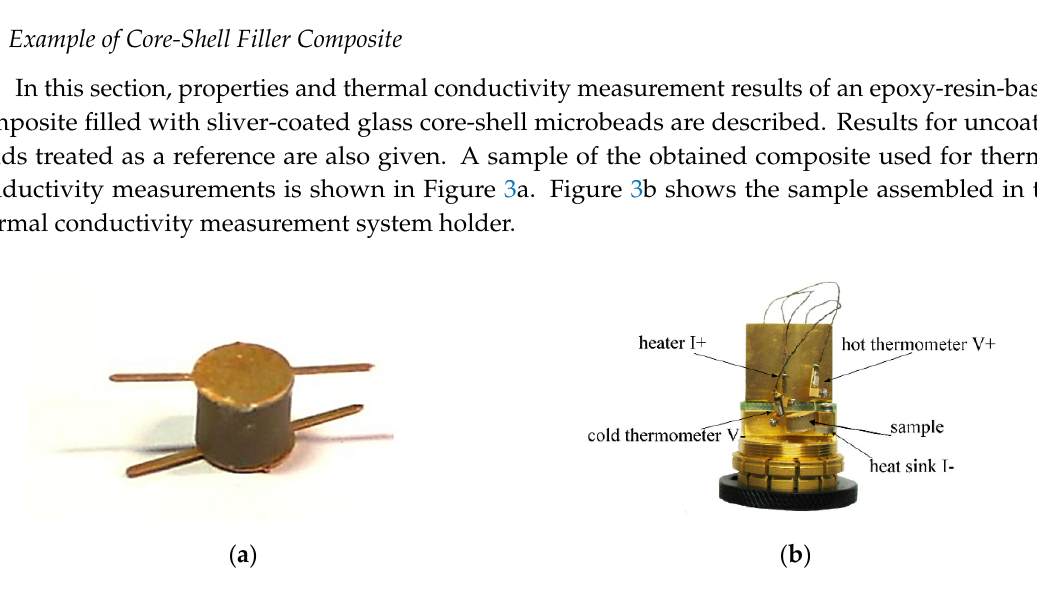
( c ) Figure 4. Scanning electron microscope (SEM) observation result for: ( a ) The core glass bead reference filler material, ( b ) the core-shell filler, and ( c ) the glass bead reference filler after silane treatment.